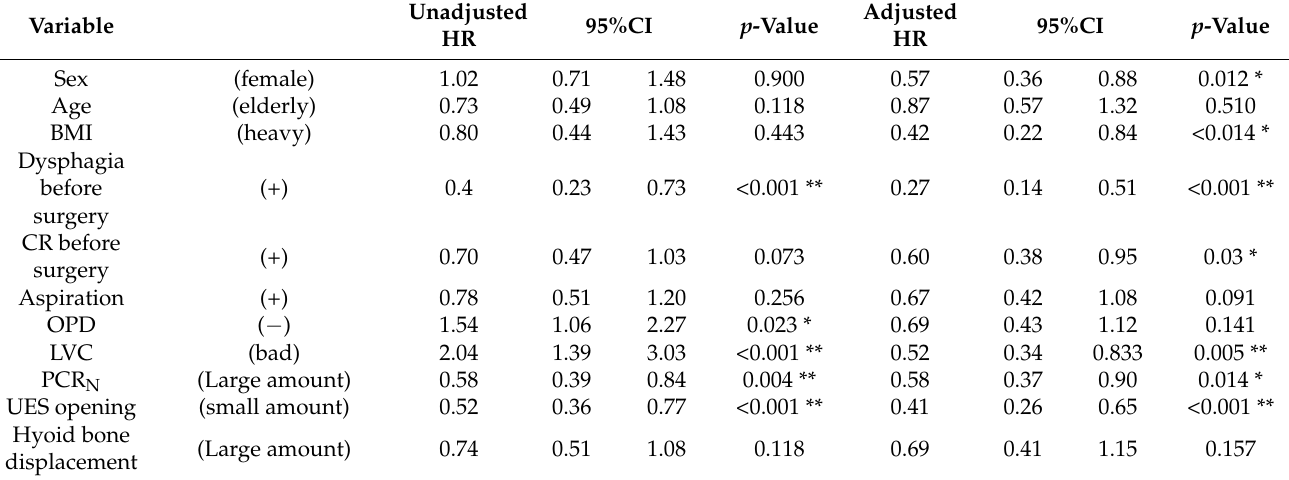
Table 3. Predictors of days until removal of the nasogastric tube, assessed using a Cox proportional hazards model. Variable